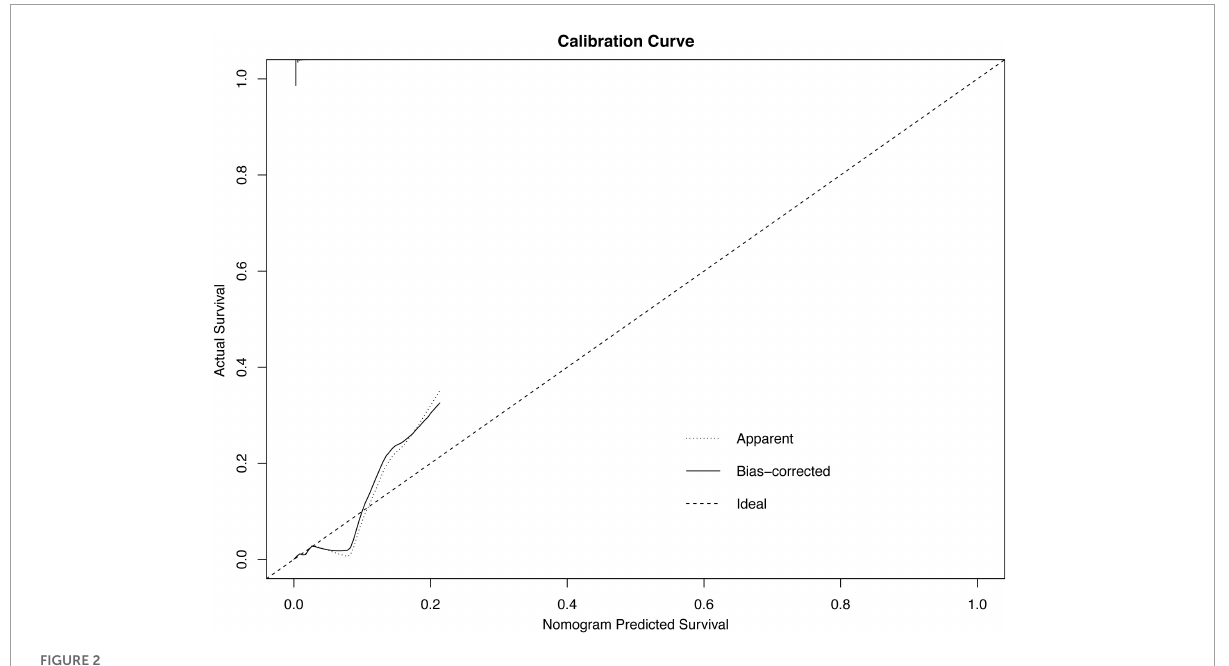
FIGURE2 Calibration plots of the nomogram.